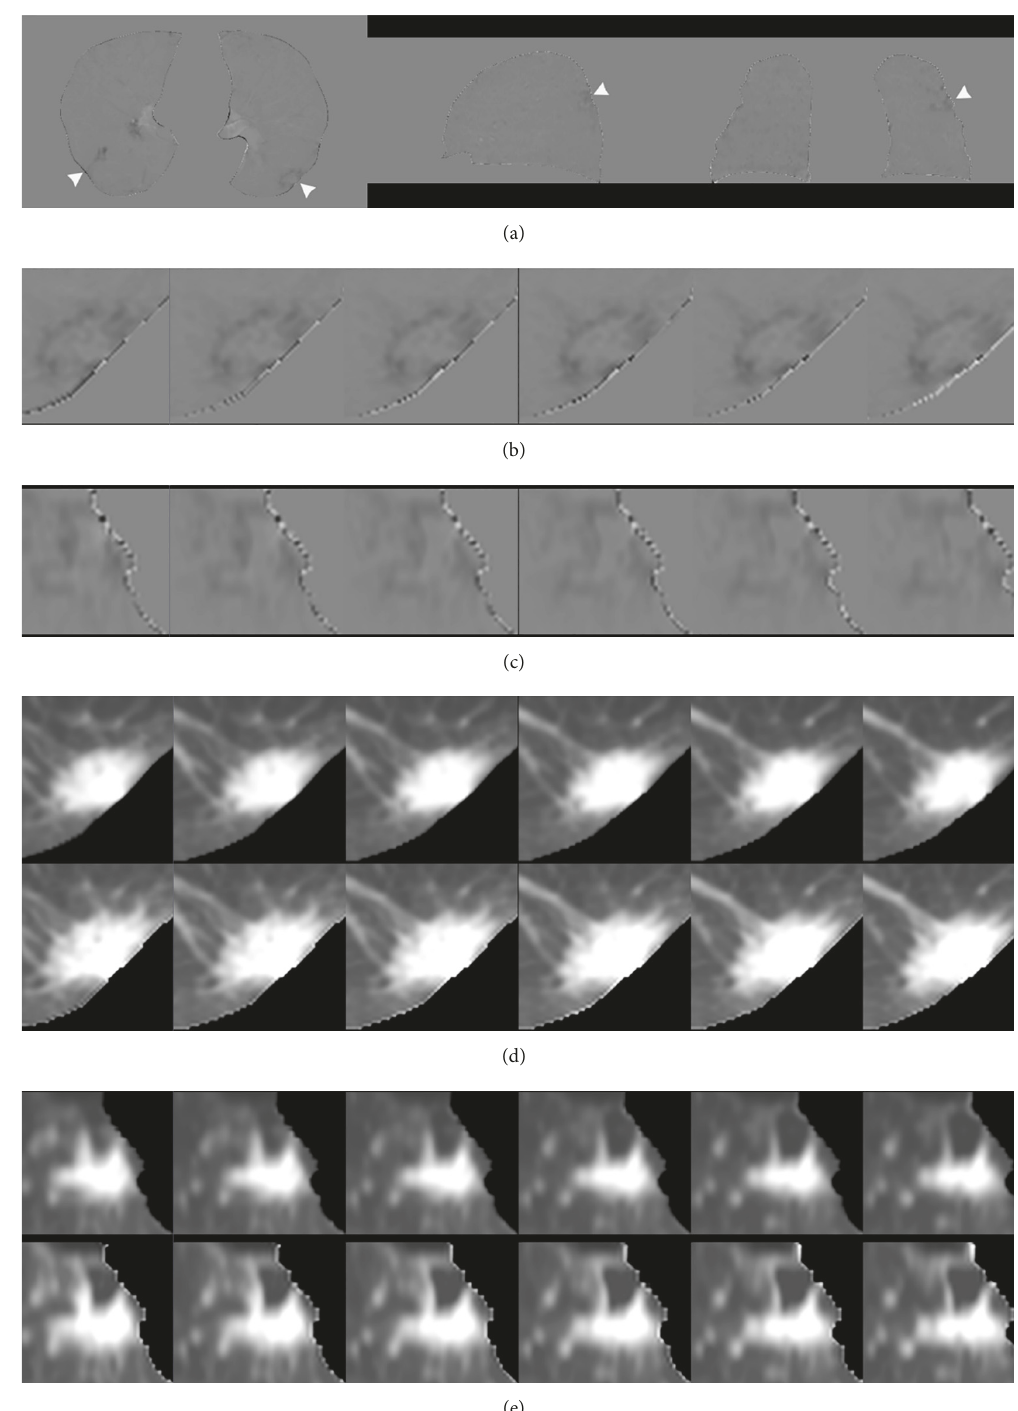
Figure 2: Sample output of the subtraction process and volume change tracker of Figure 1 after deformable image registration. The white arrows indicate the left lung lesion and right lung latent lesion. (a) Subtraction images were obtained by subtracting the warped moving images from the fixed images. (b), (c) Local enlarged subtraction images of the left lung lesion with six successive slices in the axial and coronal planes (showed clear enhanced shadows). (d), (e) Local enlarged images of lesion tissue with six successive slices and detailed comparisons of the morphological changes. In (d) and (e), the above row shows lesions in the warped moving images, while the below row shows lesions in the fixed images. No growth or shrinkage is noted. Perfectly fitted lesions are show in the two